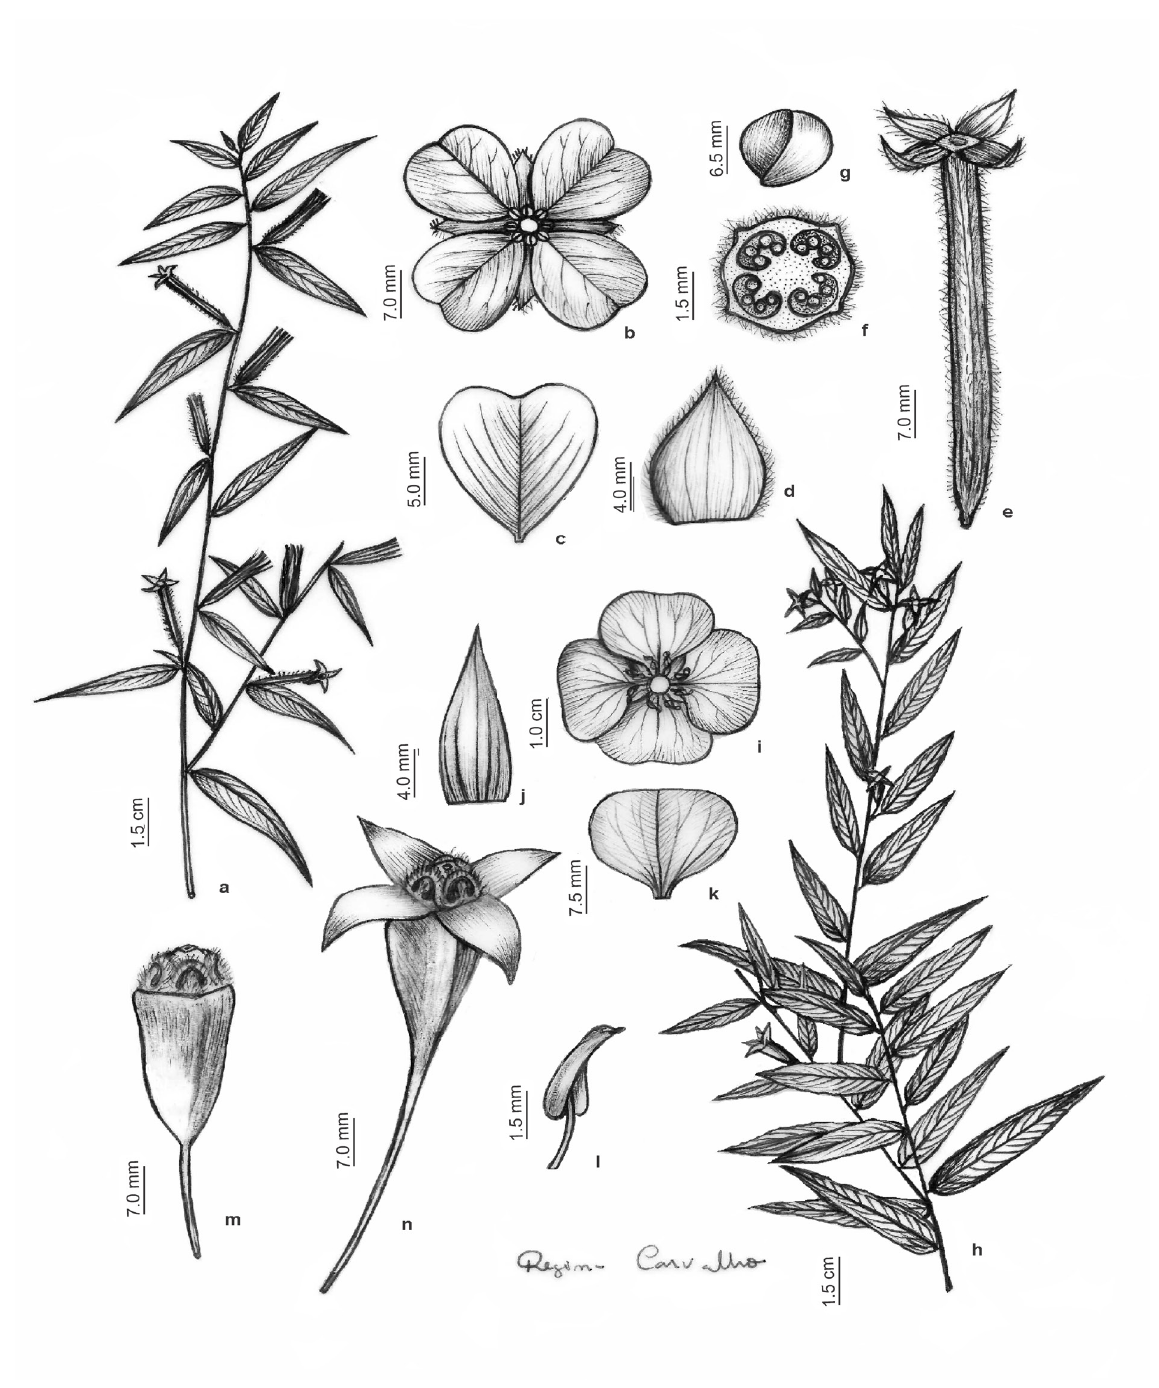
Fig. 8. a – g . Ludwigia octovalvis (Jacq.) P.H.Raven, A.M. Rocha 08 . a . Habit. b . Flower. c . Sepal. d . Petal. e . Fruit. f . Transversal cut of the fruit. g . Seed. – h – n . L. nervosa (Poir.) H.Hara, L.P. Félix et al. 3023